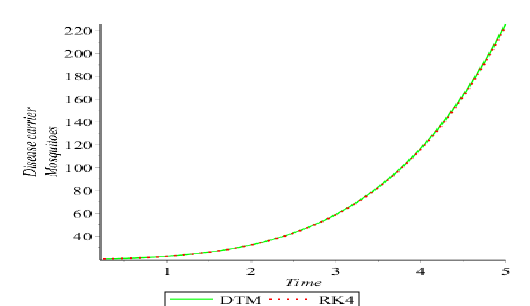
Figure 7: Solution of Non-Disease carrier Mosquitoes